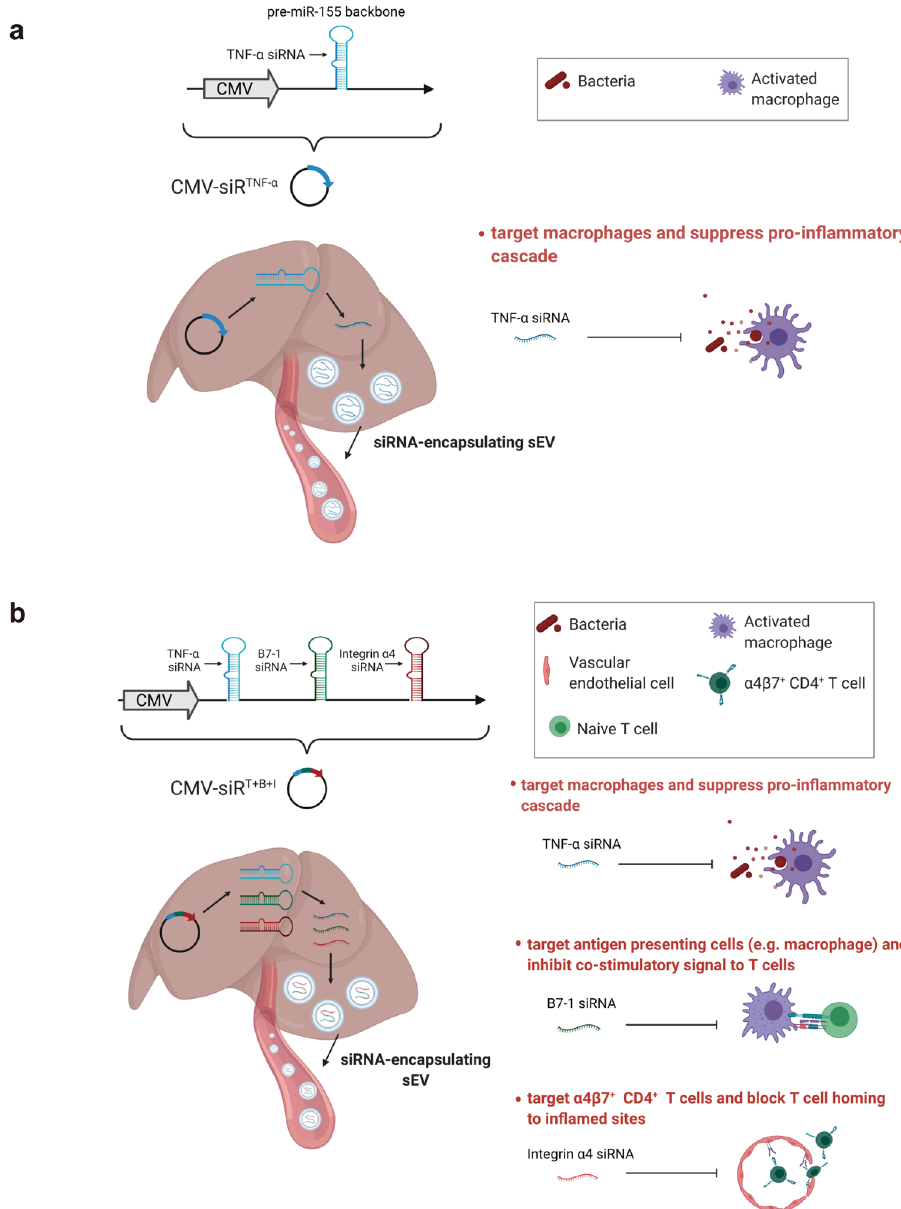
Fig. 1 | Schematic description of the architecture of the genetic circuits. a The CMV-siR TNF- α circuit contains a CMV promoter part and a TNF- α siRNA-expressing part. When the CMV-siR TNF- α circuit is taken up and processed by the liver after intravenousinjection,theCMVpromoterdrivesthetranscriptionofTNF- α siRNAin cytoplasm, which leads to the loading of saturated TNF- α siRNA into small extra- cellular vesicles (sEVs) as cargo. Subsequently, TNF- α siRNA-encapsulating sEVs facilitate the systematic distribution of siRNAs to multiple tissues and cells, including colonic macrophages. Once arriving colonic macrophages, TNF- α siRNA hasthepotentialtoregulateimmunebalanceandrelieveintestinalin fl ammationby